Question: Condense the content of this figure into a single sentence.
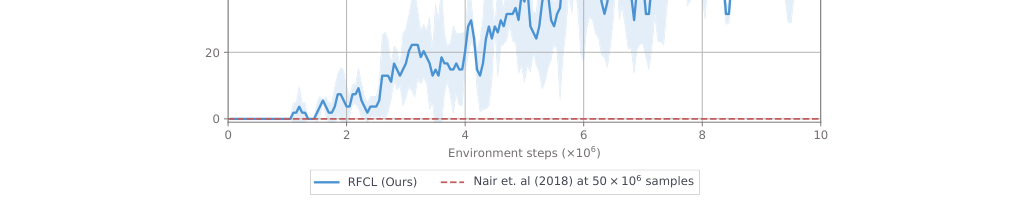
Answer: compares our RFCL method with the state reset method proposed by Nair et al. (2018) on the difficult Stack 3 task, which tasks the agent to stack 3 blocks into a tower. We label their method as Nair et. al (2018). Our approach vastly outperforms their method by being able to solve the task in less than 10 million samples with just 20 demonstrations whereas Nair et al. (2018) requires more than 100 million samples using 100 demonstrations to just get a 39% success rate and has 0 success even after 50 million samples (see their paper for their exact success rate curves). We note that while RFCL performs better, this comparison is a little unfair as the core RL algorithms used are different between papers (hence why this figure is in the appendix). For a more fair comparison we benchmarked the state reset strategy Nair et al. (2018) uses in Table 1 while keeping the rest of RFCL the same, which still shows that our per-demo reverse curriculum is far more sample efficient compared